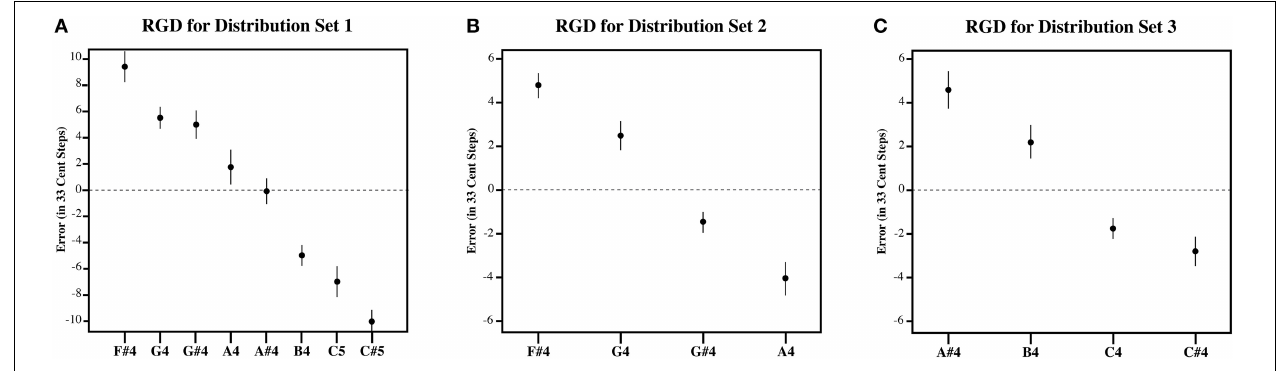
FIGURE 6 | The plot of the estimation error in 33-cent steps for each tone for the RGD. (A) Shows the RGD for set 1, (B) shows the RGD for set 2, and (C) shows the RGD for set 3. Note that the RGD bisects the presented